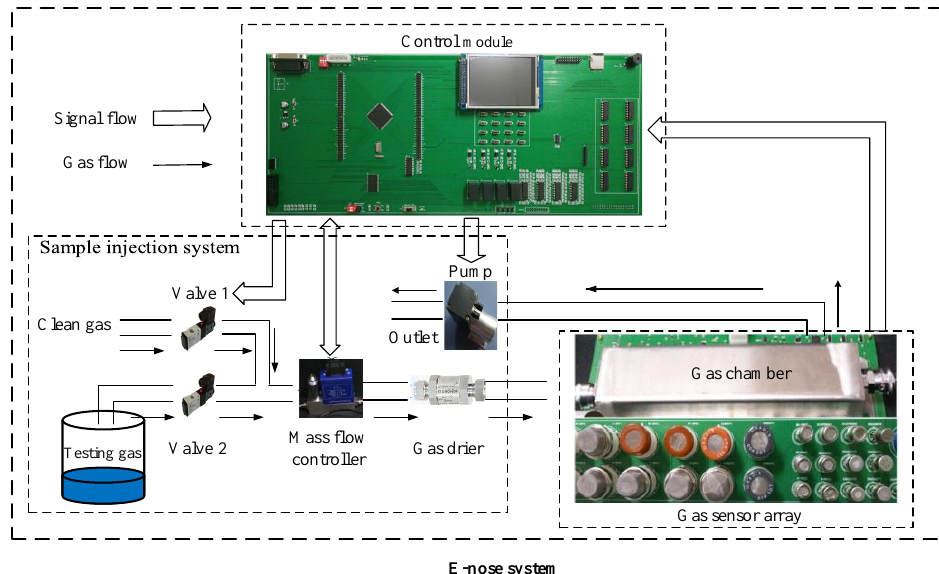
Figure 4. Structure of our E-nose system. Table 2. Gas sensor details of our E-nose